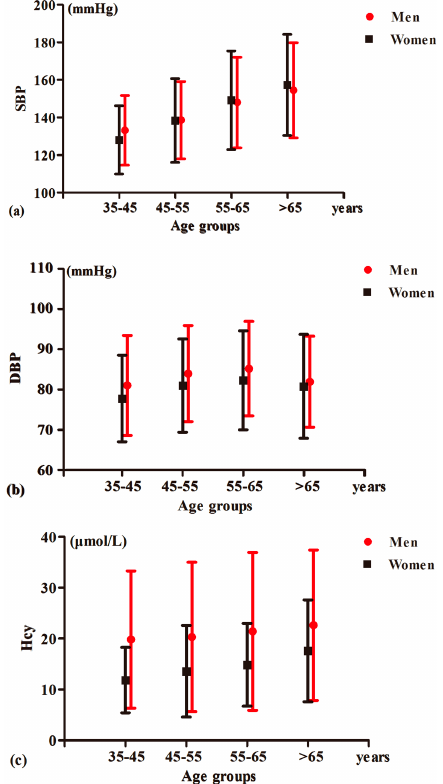
Figure 1. The association between SBP ( a ); DBP ( b ); and Hcy ( c ), with age in both genders. The values of SBP, DBP, and Hcy are expressed as mean ± SD. Abbreviations: DBP: diastolic blood pressure; Hcy: homocysteine; SBP: systolic blood pressure; SD: standard